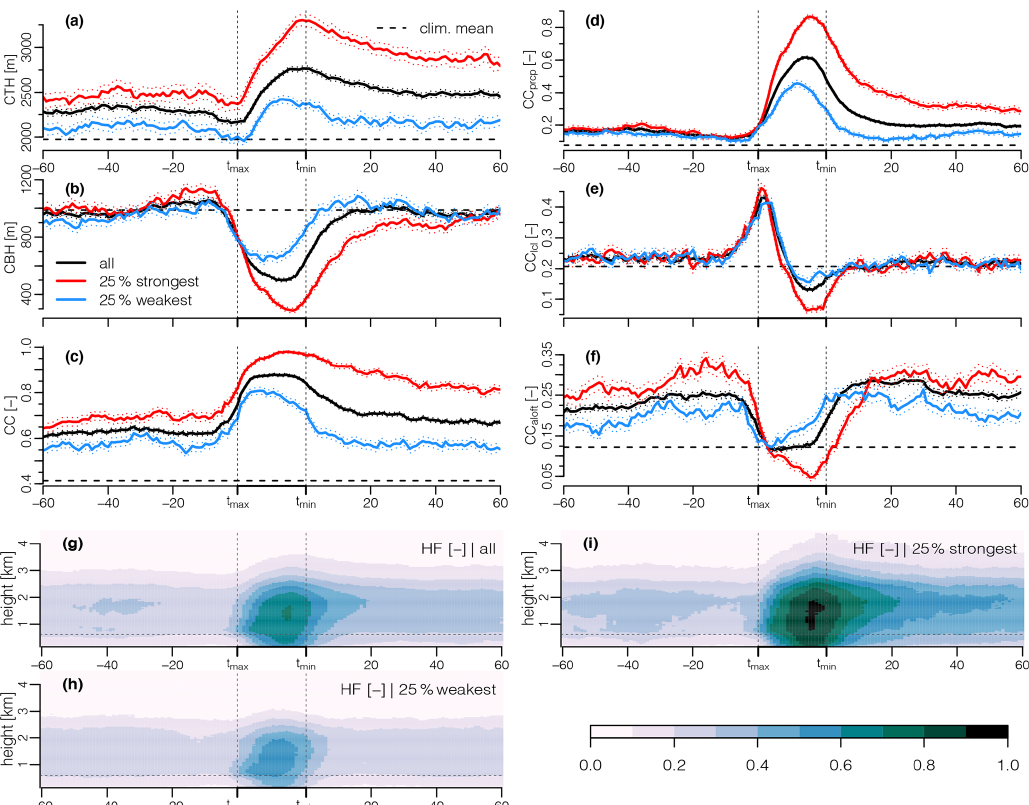
Figure 4. (a–f) Same as Fig. 3 but for (a) cloud-top height, (b) cloud-base height, (c) total cloud cover, and the contribution to total cloud cover from (d) CC prcp , (e) CC lcl , and (f) CC aloft . Also indicated is the climatological mean value for the winter periods of 2012–2020. (g–i) Composite mean temporal structure of vertical hydrometeor fraction (HF) profiles for all noprevWI cold pools as well as the 25% strongest and weakest. The thin dashed line at 600m height marks the typical base of the cumulus